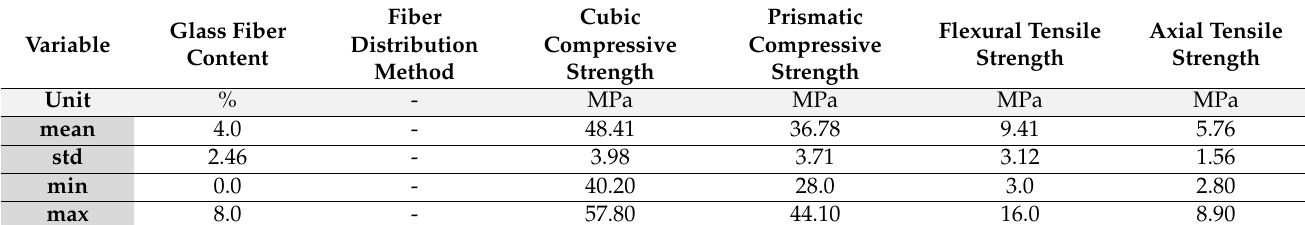
Table 2. Statistical characteristics of the